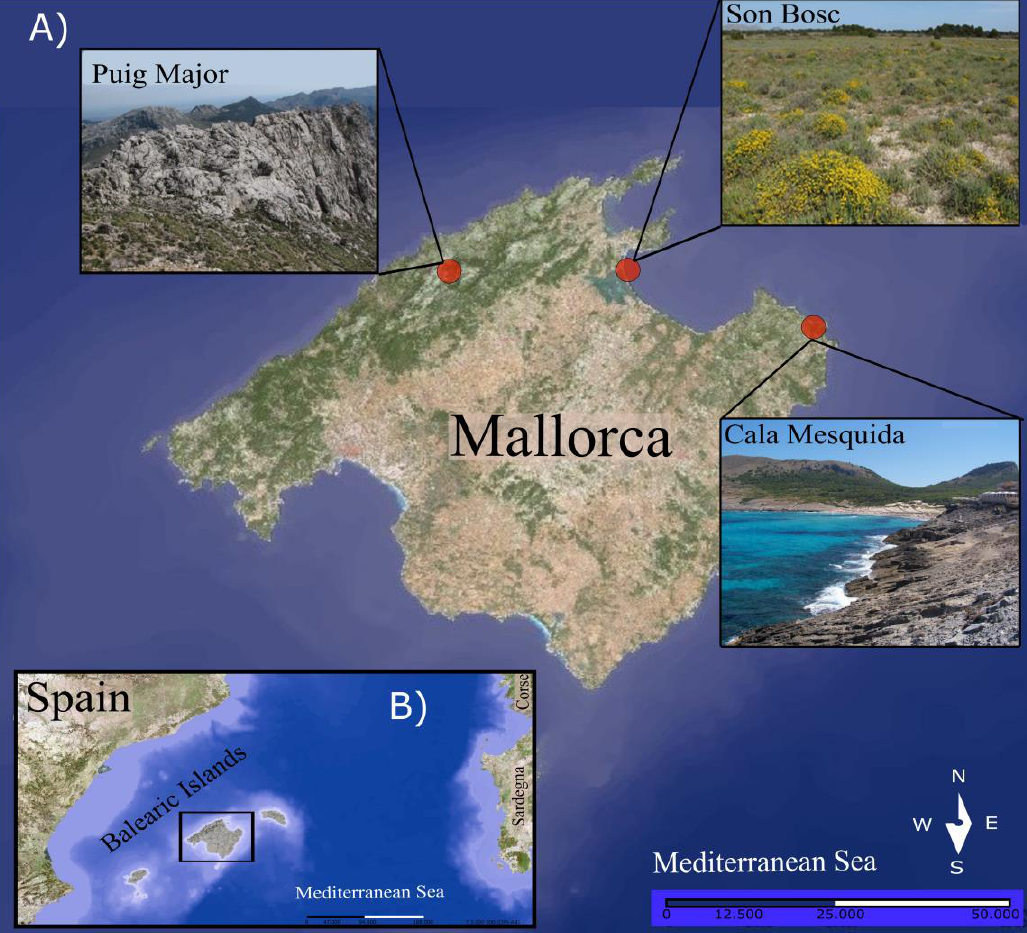
Figure 1. A) Study sites encompassing the three different communities on Mallorca Island. Son Bosc a coastal dune community, Cala Mesquida a rocky coastal community and Puig Major, a mountain community. B) Geographic position of Mallorca Island in the western Mediterranean